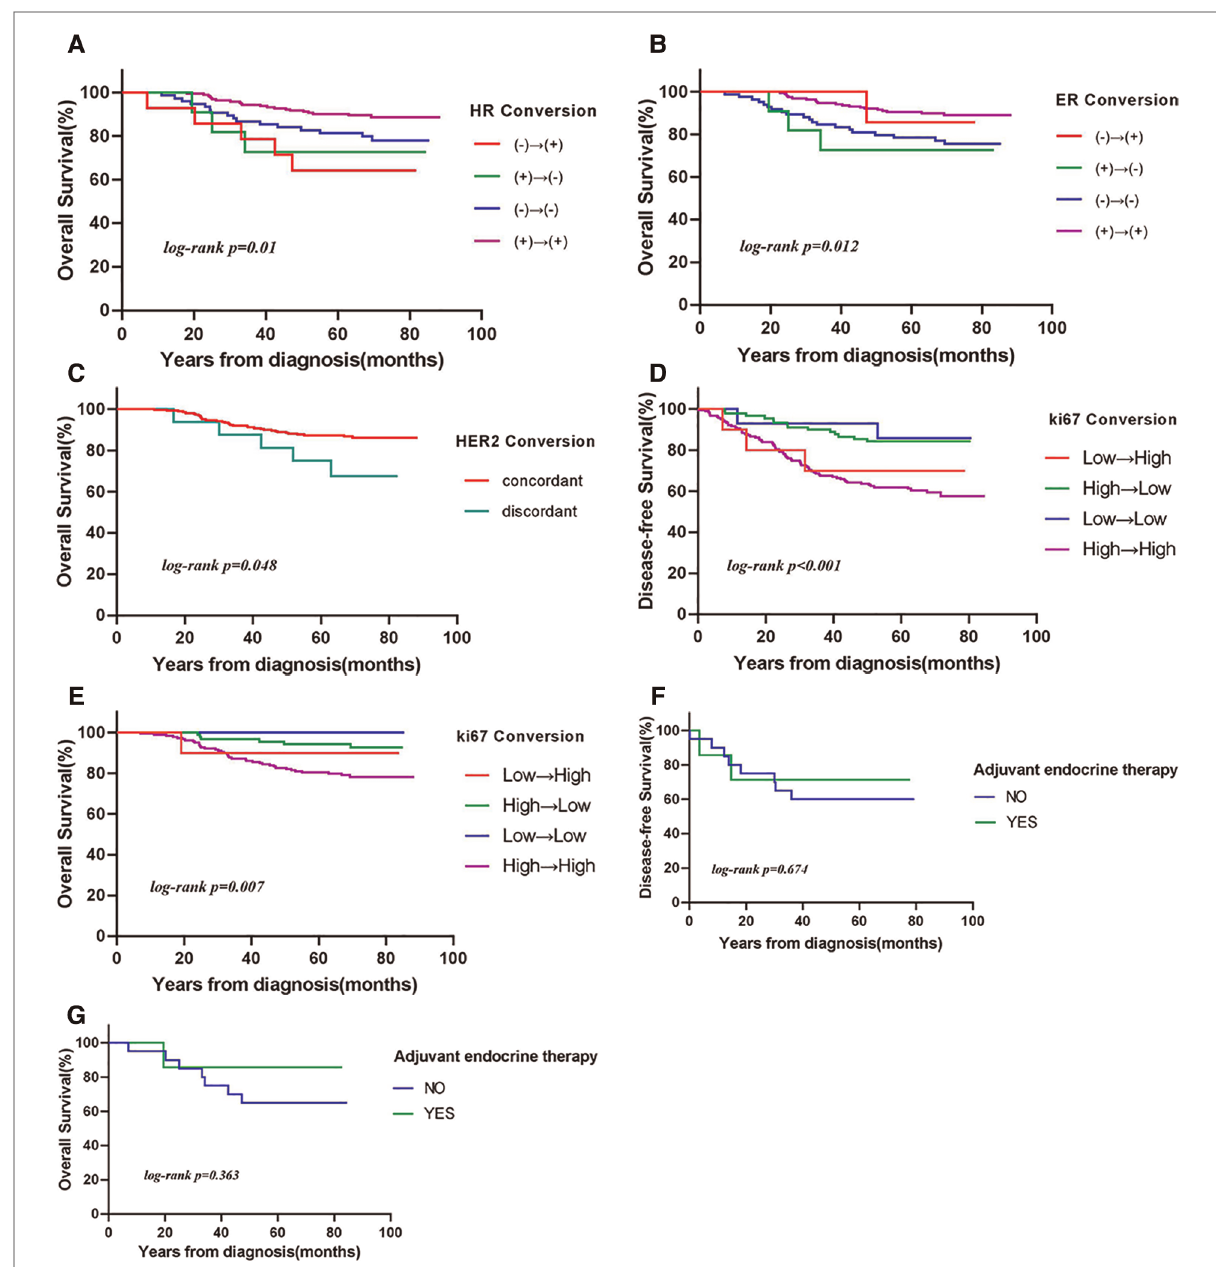
conversion [( D ) DFS: P <0.001; ( E ) OS: P =0.007], and ( F,G ) HR conversion in patients treated with endocrine therapy [( F ) DFS: P =0.674; ( G ) OS: P